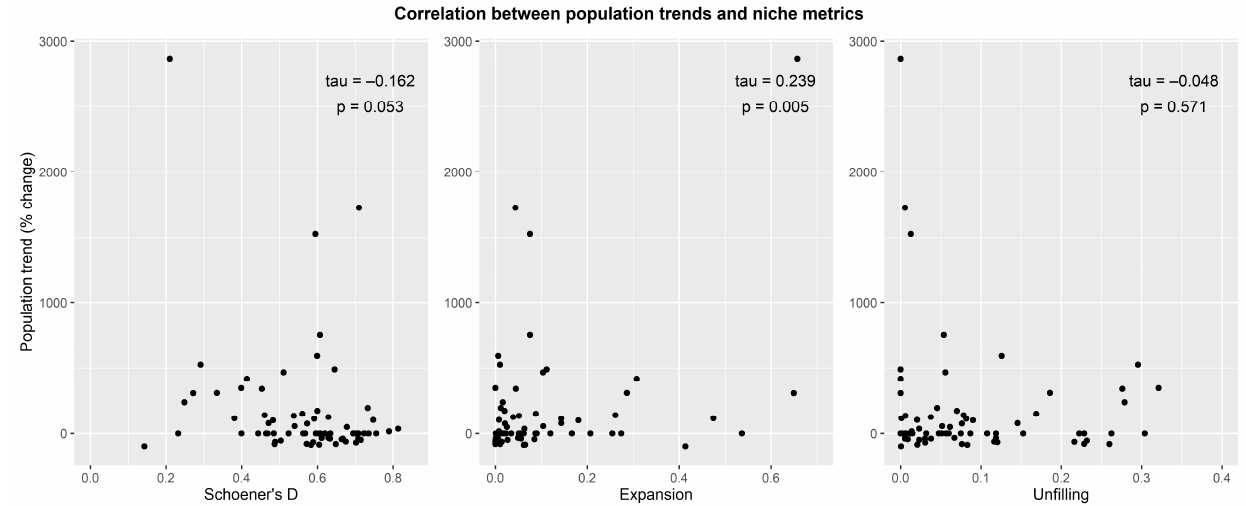
Figure 5. Kendall correlation between species population trends and niche metrics. Each dot represents a species ( n = 71). Species population trends were reported as percentage of change (% change) of the population index from 1992 to 2019. Values of % change below zero indicate decreasing populations. Kendall’s rank coefficient tau and the corresponding p -values (p) are shown in the upper right corner.